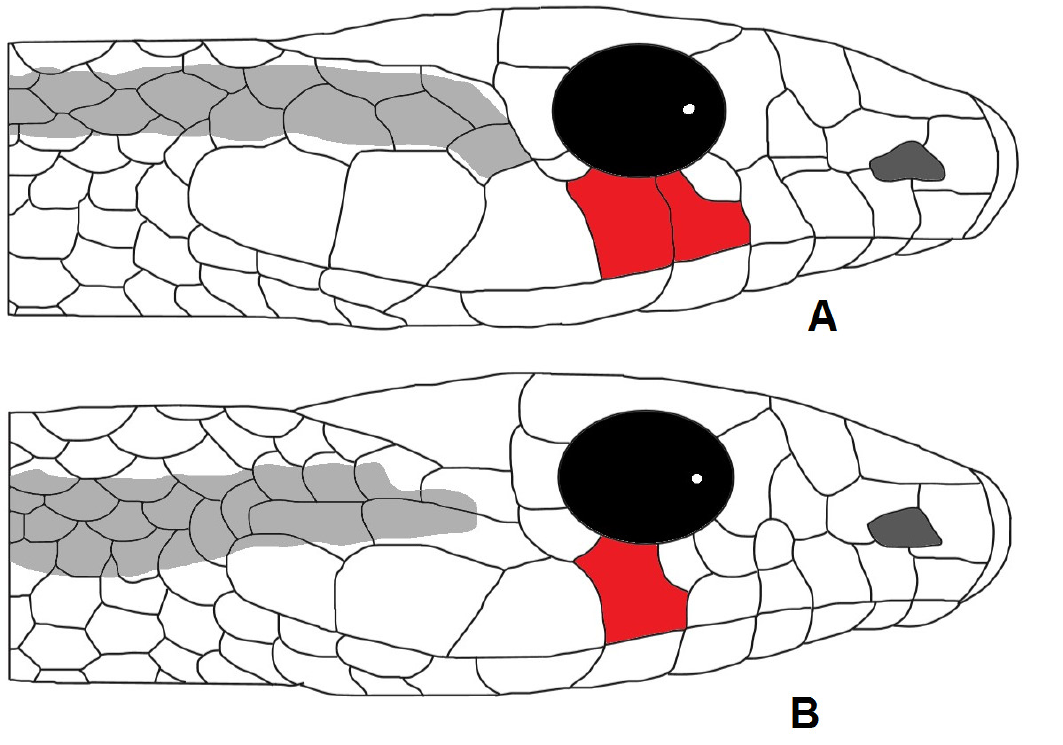
European Journal of Taxonomy 764: 85–118 (2021) Fig. 19. A . Two supralabials reaching the eye. B . Fewer than two supralabials reaching the eye. Fig. 20. A . Two or more subocular scales. B . One supralabial in contact with the eye.